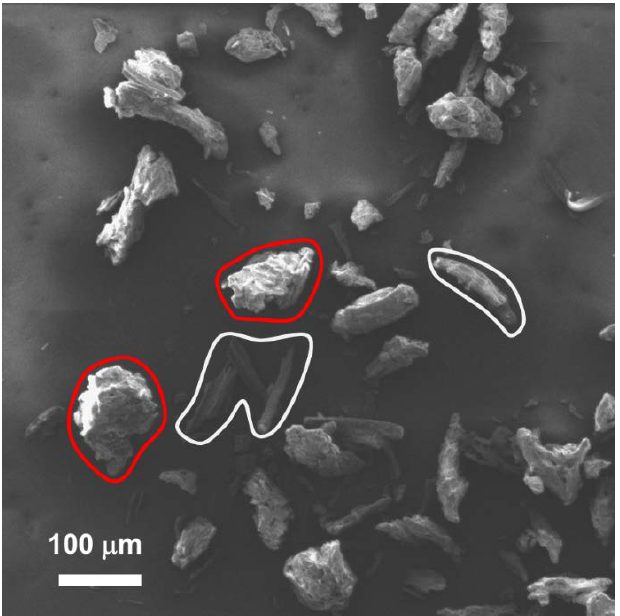
Figure 2. SEM image of a physical mixture of cellulose and AC-Air carbon catalyst. Cellulose particles are encircled in red, and AC-Air particles are encircled in